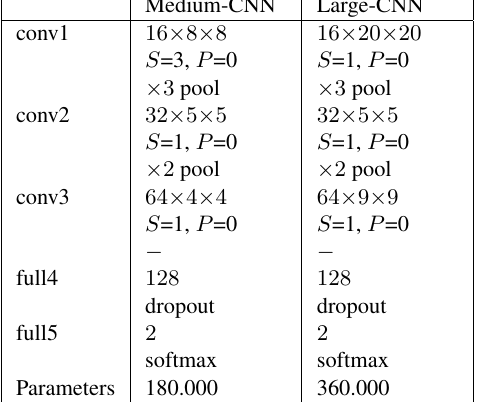
Figure 10 the training on the LiDAR elevation (F-Score: 0 . 903 )